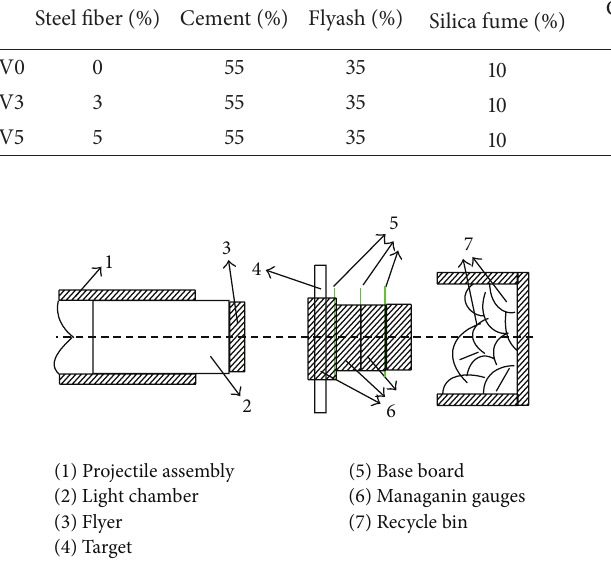
Figure 1: Setup of the